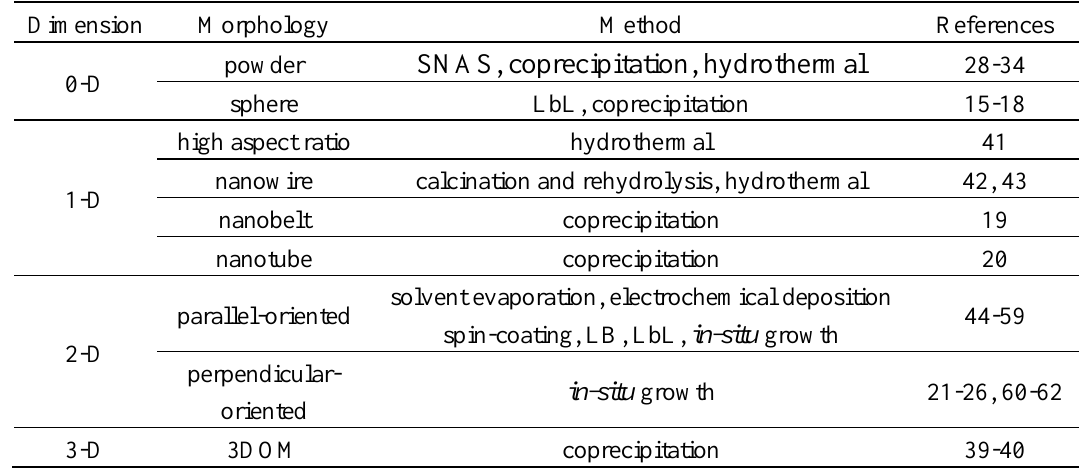
Table 1. Overview of the LDH micro-/nanostructures with different dimensions and synthesis. Dimension Morphology